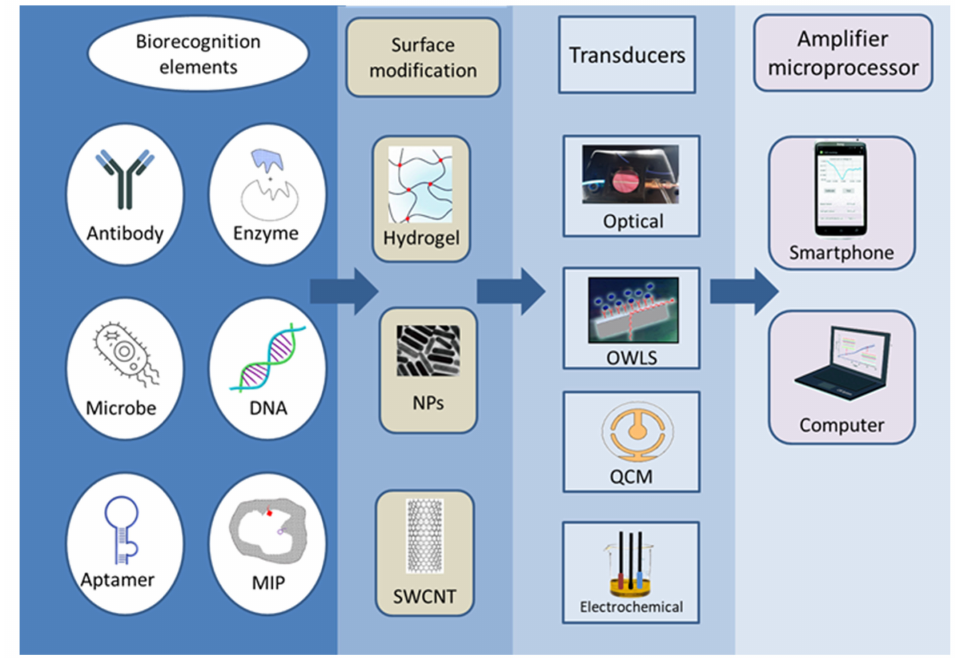
Figure 2. The diversity of the construction possibilities of biosensor